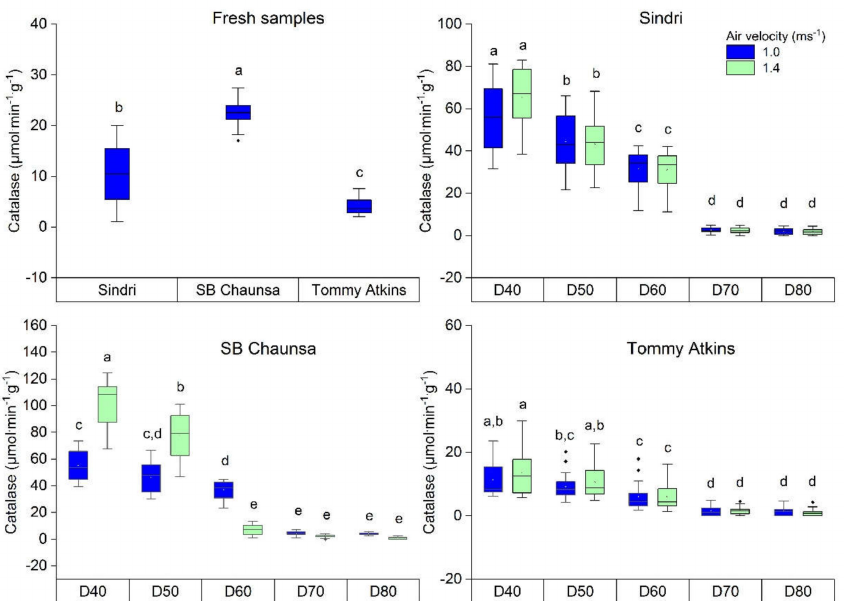
Figure 3. Catalase activity in fresh and dried mango of the varieties Sindri, SB Chuansa, and Tommy Atkins, respectively; D = dried samples treated at temperatures 40 ◦ C to 80 ◦ C. a–e values in box plot with di ff erent superscripts are significantly di ff erent under the limit of p < 0.05, ( n = 20 ×